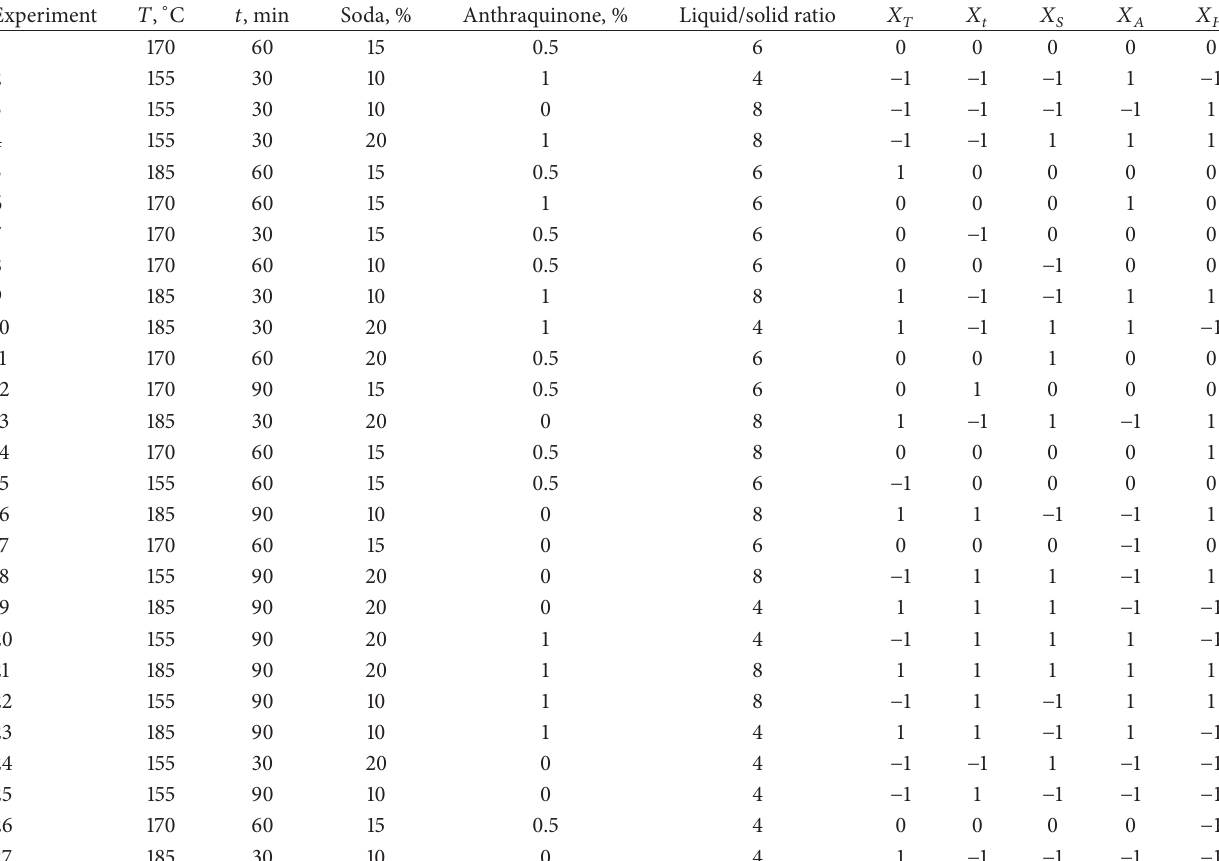
Table 1: Values of operating variables used in the design of